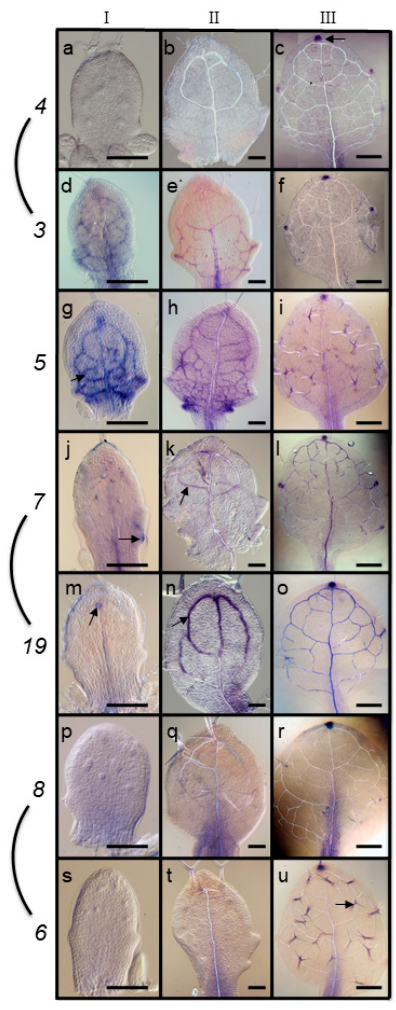
Figure 1. ARF gene expression patterns in developing leaves (blue / purple stain). ( a – c ) ARF4 , ( d – f ) ARF3 , ( g – i ) ARF5 / MP , ( j – l ) ARF7 , ( m – o ) ARF19 , ( p – r ) ARF8 , ( s – u ) ARF6 . Arrows indicate examples of expression in apex hydathode ( c ), preprocambial / procambial ( d ), procambial cells